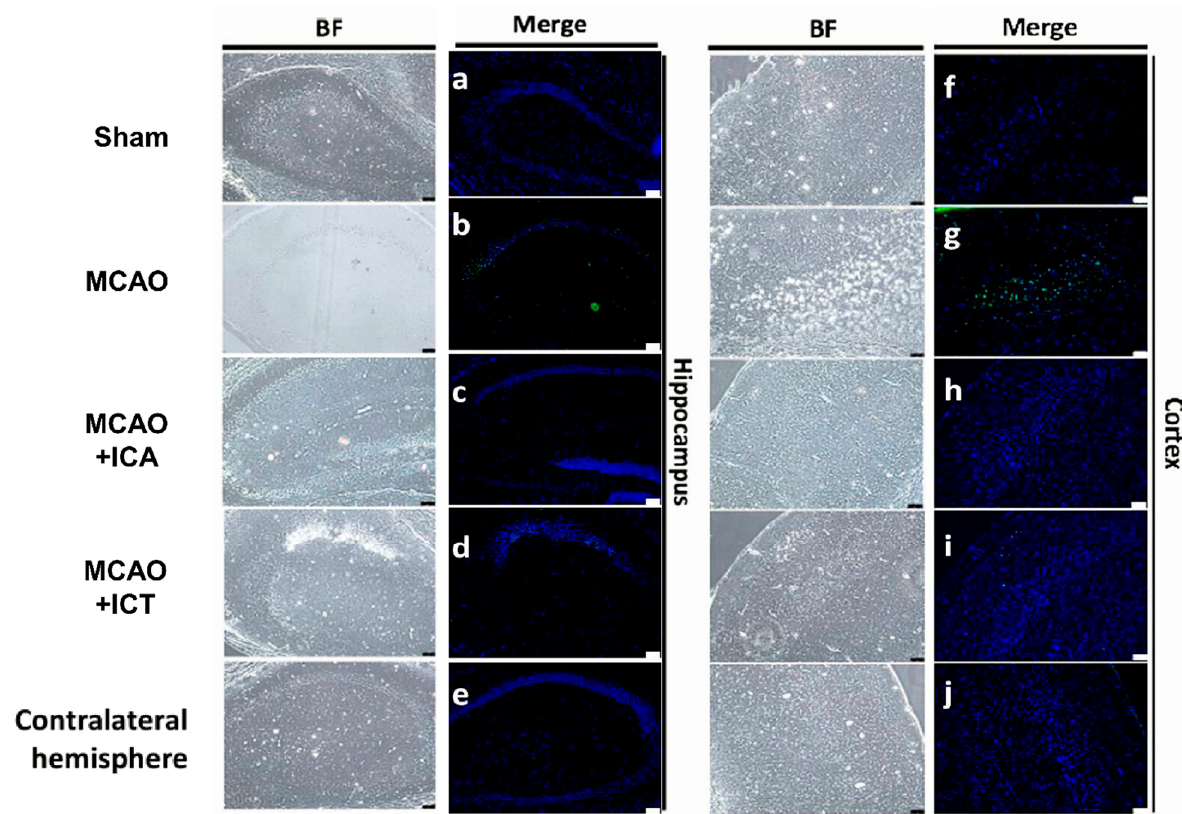
Figure 3. Both ICA and ICT treatment inhibited the neuronal cell apoptosis in the left cerebral hemisphere of mice with acute cerebral ischemia–reperfusion. TUNEL staining was used to detect neuronal apoptotic cells in the hippocampus (( a ), Sham; ( b ), MCAO; ( c ), MCAO+ICA; ( d ), MCAO+ICT; ( e ), Contralateral hemisphere) and cortex (( f ), Sham; ( g ), MCAO; ( h ), MCAO+ICA; ( i ), MCAO+ICT; ( j ), Contralateral hemisphere). TUNEL-positive cells were presented as a fluorescent green color, while cell nuclei were displayed as a fluorescent blue color. Scale bar = 75 µm. BF: bright field. The results are representative of at least four independent experiments.